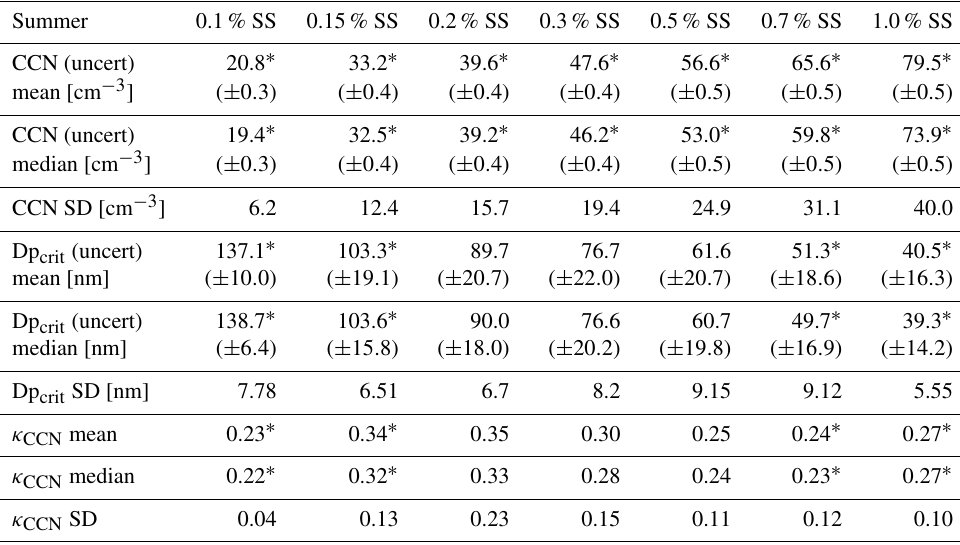
Figure 6. CCN properties at various SSs during the summer measurement period. (a) Particle and CCN number concentration, (b) critical activation diameter (Dp crit ), and (c) κ CCN value. Black line: total particle number concentration inferred from SMPS measurements ( N tot ), gray line: number concentration of particles > 25nm ( N 25 ), colored symbols: CCN measurements at 0.1%–1.0% SS. Table 3. Statistics of CCN measurements for the summer field study. The uncertainty values stated with CCN mean, CCN median, Dp crit mean, and Dp crit median are the respective statistics of the associated uncertainty found in the fitting procedure. The values of SD are the standard deviations of the parameter distributions over the temporal evolution of the study. The asterisk ( ∗ ) signifies a significant difference between spring and summer field studies (Wilcoxon rank sum test, p < 0 . 05). CCN measurements for the summer field study were obtained from 15 August to 2